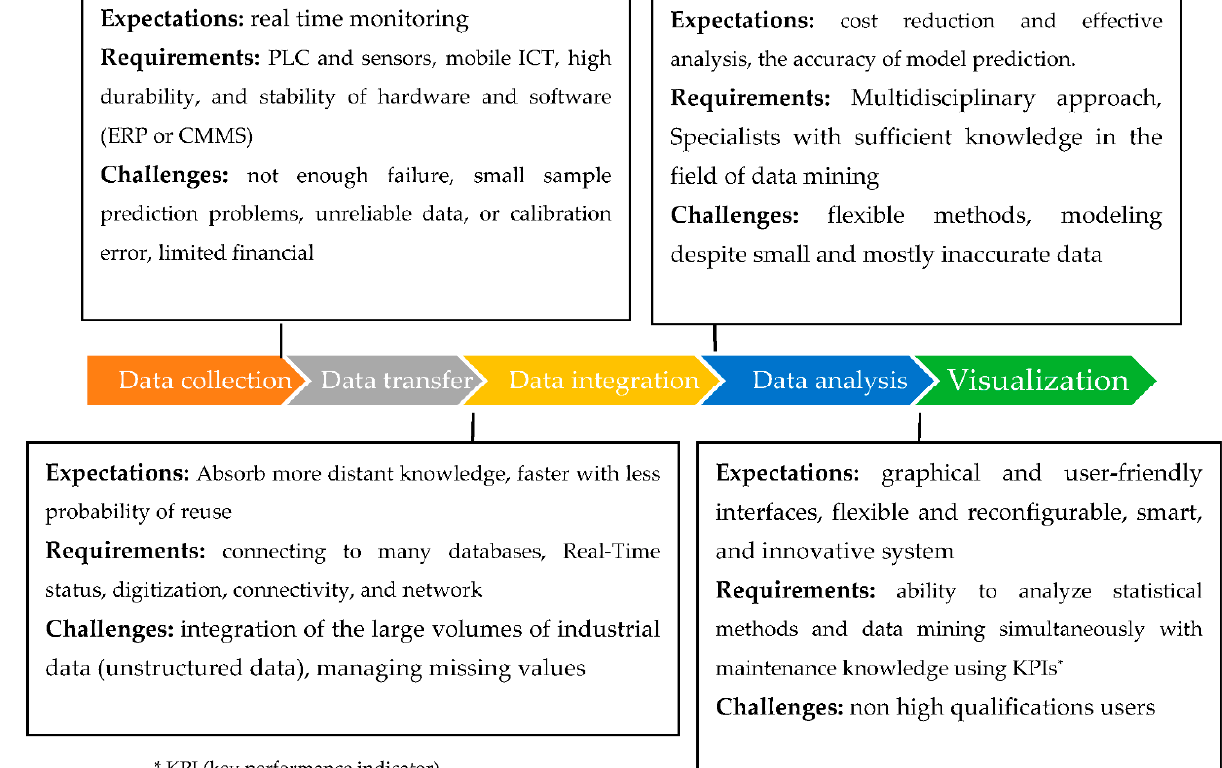
Figure 8. Expectations, requirements, and challenges in the field of predictive maintenance based on implementation phases.